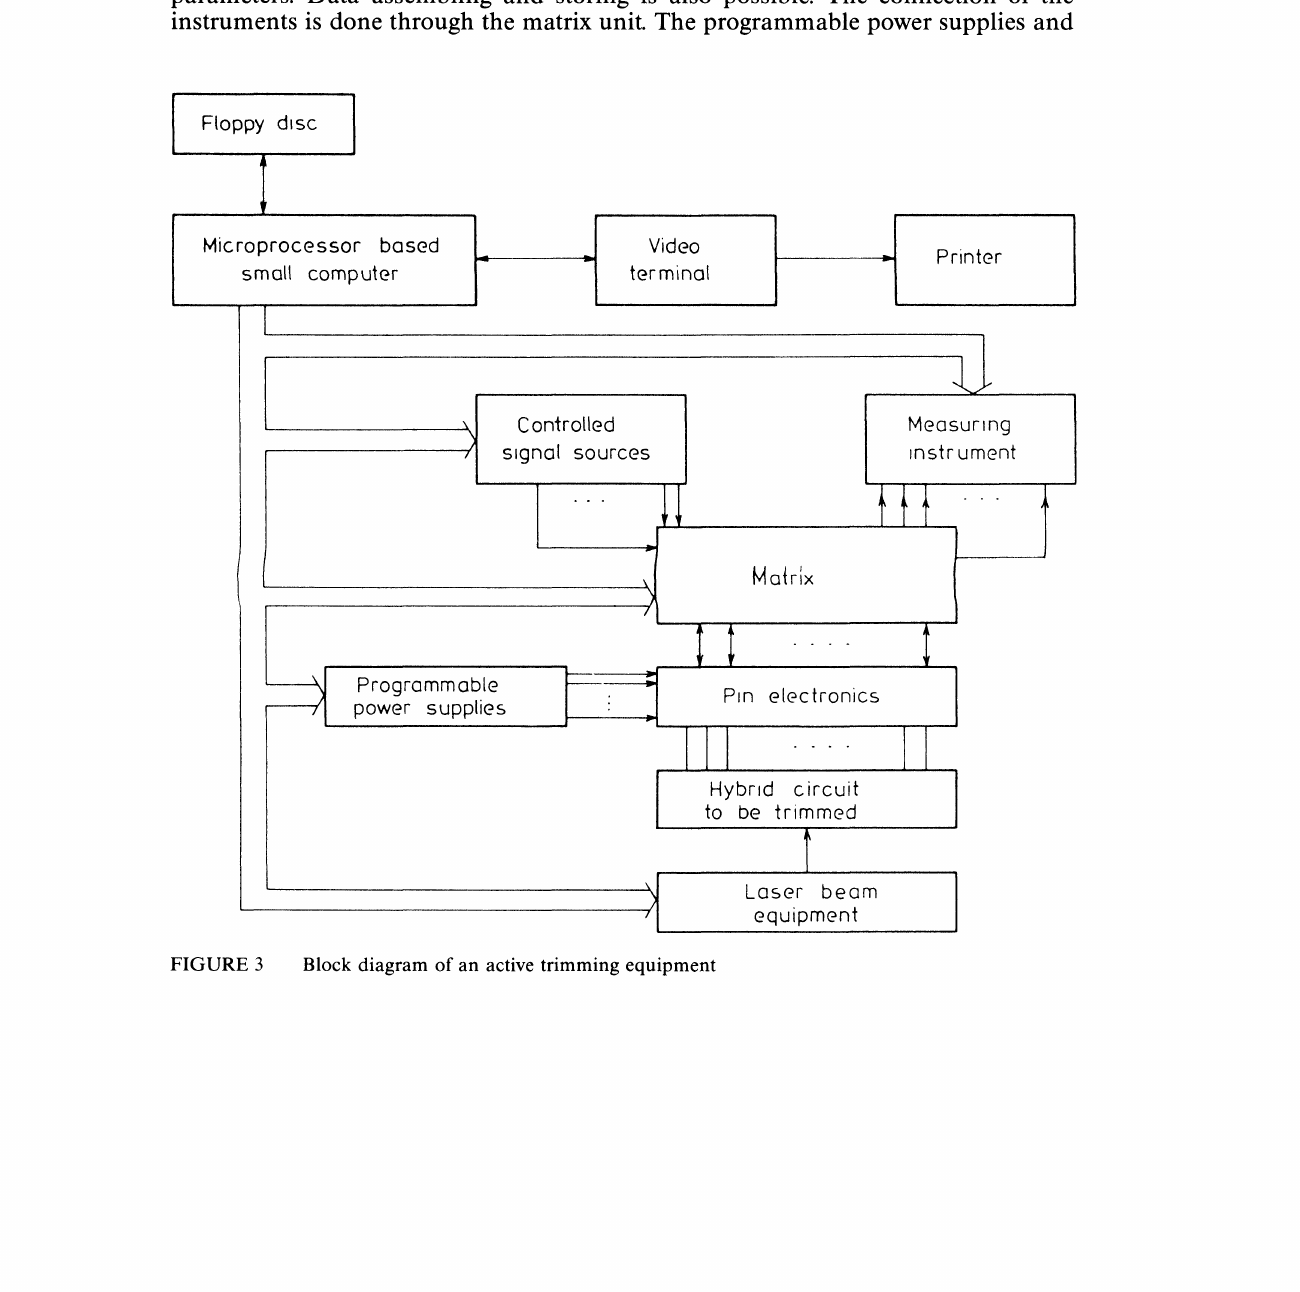
Block diagram of an active trimming